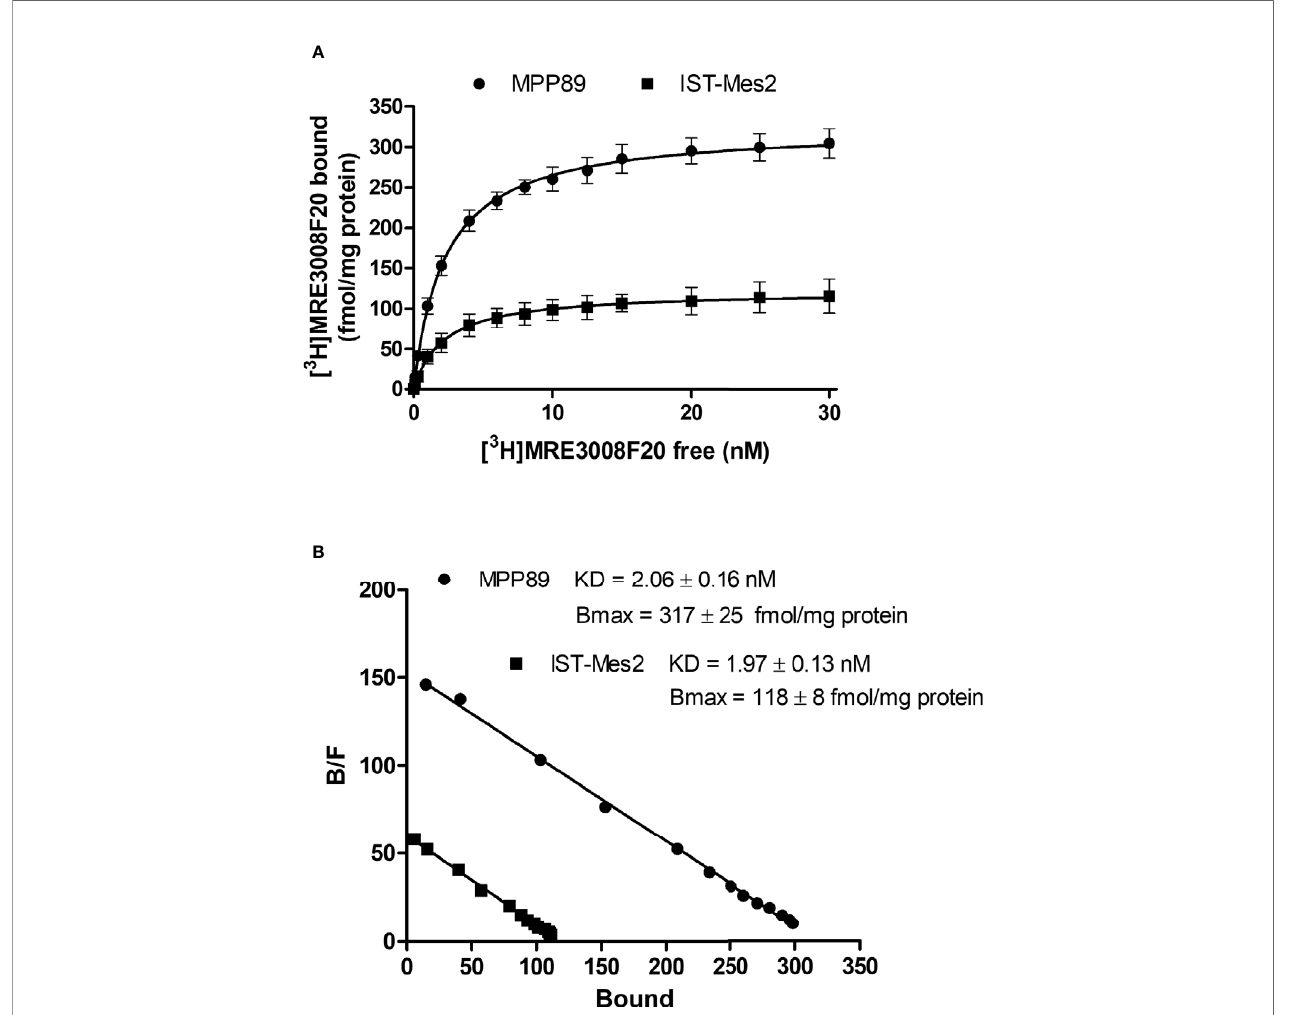
FIGURE 1 | A 3 AR saturation binding experiments. Saturation curves (A) and relative Scatchard plots (B) of [ 3 H]-MRE3008F20 binding on IST-Mes2 and MPP89. Results are represented as mean ± standard error of mean (SEM) of n=3 independent experimental